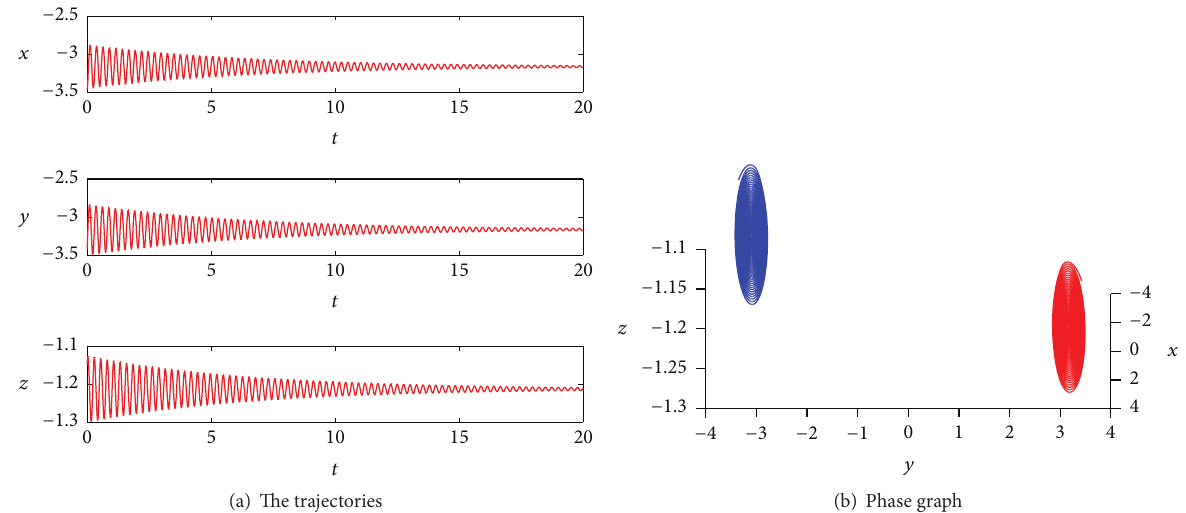
Figure 5: The trajectories and phase graphs of system with 𝜏 = 0.0405 > 0.0397 , 𝑘 = −25 at initial values of phase graphs: 𝐸